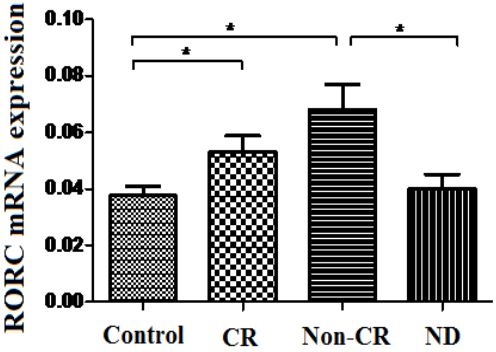
Figure 5. The mRNA expression of RORC expression in AML patients and healthy controls. The data represent the means ± SD and * p <